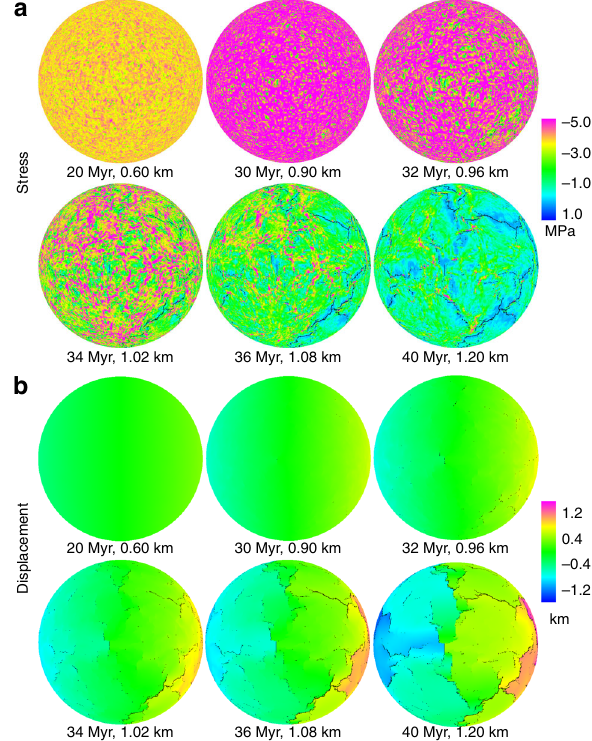
Fig. 1 Plate-breaking reference model. The reference model shows the progressive development of a global fracture network in response to displacement-controlled increasing interior pressure (at 0.03 km per million years (Myr)) applied to an 80-km-thick lithosphere. a These spheres show the global surface distribution of minimum principal stress magnitudes through time (negative values denote tensile stress, positive values denote compressive stress). b These spheres show the associated displacement (articulated along a horizontal axis, from left to right through each sphere ’ s center). In both a and b , surface elements which attain their ultimate tensile strain are displayed as fractures in black. At 20 Myr, the single-plate lithosphere remains macroscopically undamaged. At 30 – 32 Myr, with sustained interior pressure, cracks initiate and propagate. By 34 Myr, crack coalescence generates features such as triple junctions. By 40 Myr, with the intersection of most major crack systems, the global fracture network is established, dividing the surface of the sphere into plate-like segments. Supplementary Fig. 4 shows this model in greater detail, with sets of 15 spheres extending from 10 to 100